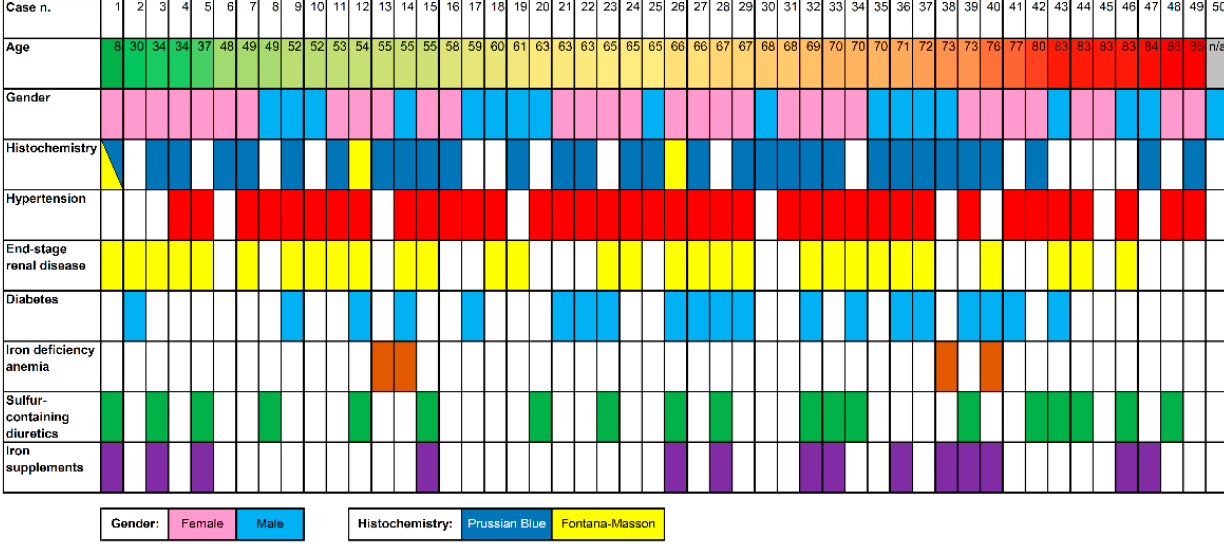
Figure 2. A heatmap visualization of the 51 cases of duodenal pseudomelanosis included in this review, with data on patients’ age, gender, histochemical stains positivity, relevant comorbidities, and medical